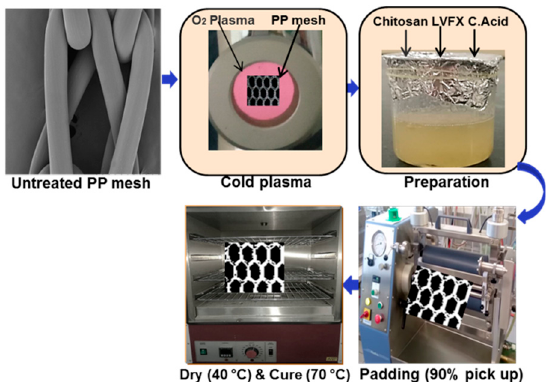
Figure 1. Illustrations and experimental design of chitosan and levofloxacin HCl-coated polypropylene (PP) meshes.